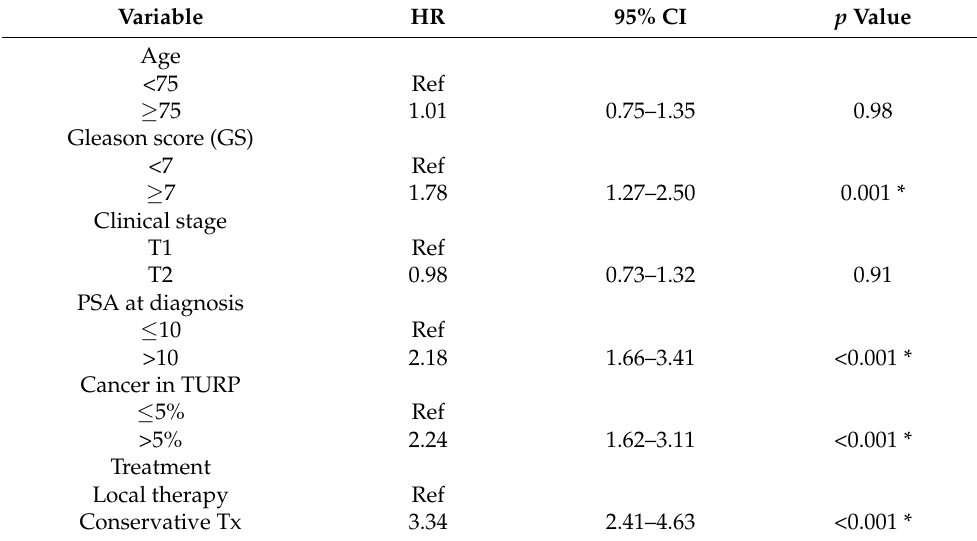
Figure 3. Tumor involvement in TURP prostatic tissue correlated with clinical outcome of patients with localized prostate cancer. Kaplan-Meier PFS survival curves of patients stratified by the percent- age of tumor involvement in TURP specimens ( a ). Additional, local therapy significantly improved PFS in patients who produced TURP specimens with >5% tumor involvement but did not significantly benefit those with ≤ 5% tumor involvement ( b ). Table 1. Adjusted hazard ratio of determine factors associated with the biochemical progression-free survival for 687